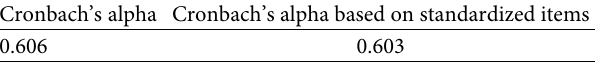
Table 14: Reliability statistics.